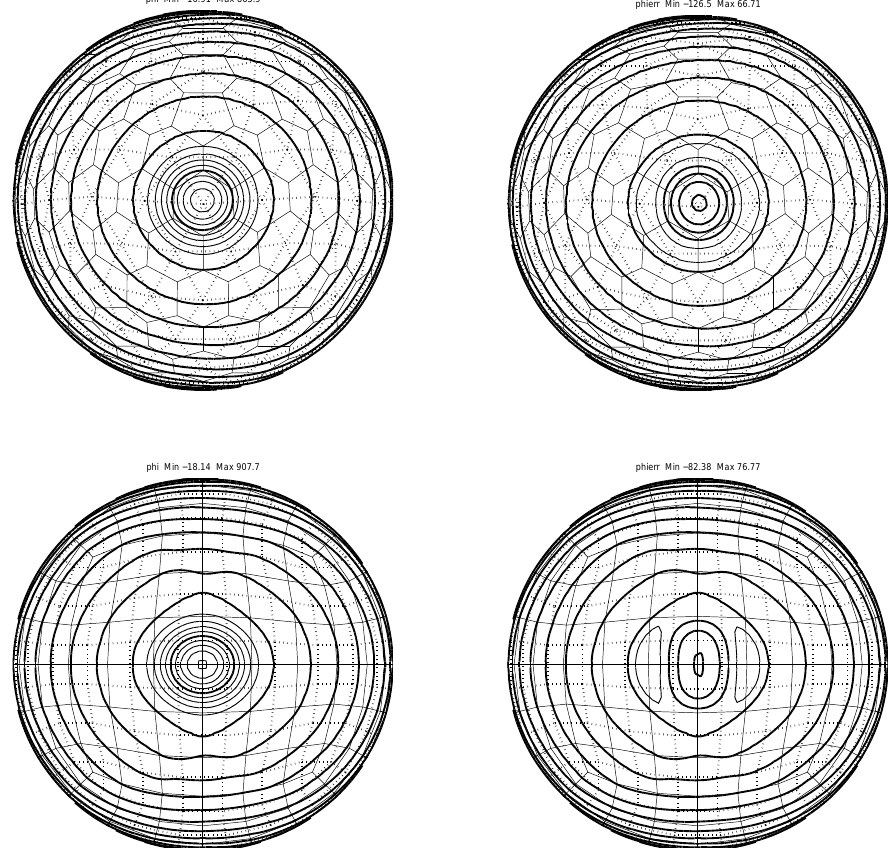
Figure 4. Cosine bell advection test. Left: final φ field, contour interval 100; 0 and 500 contours are bold. Right: final error field, contour interval 40; negative and zero contours are bold. Top: hexagonal–icosahedral grid with 10242 cells. Bottom: cubed-sphere grid with 13824 cells. A quadratic subgrid fit was used with a time step of 1800s. The coarse-resolution grids shown in the background are for orientation only.